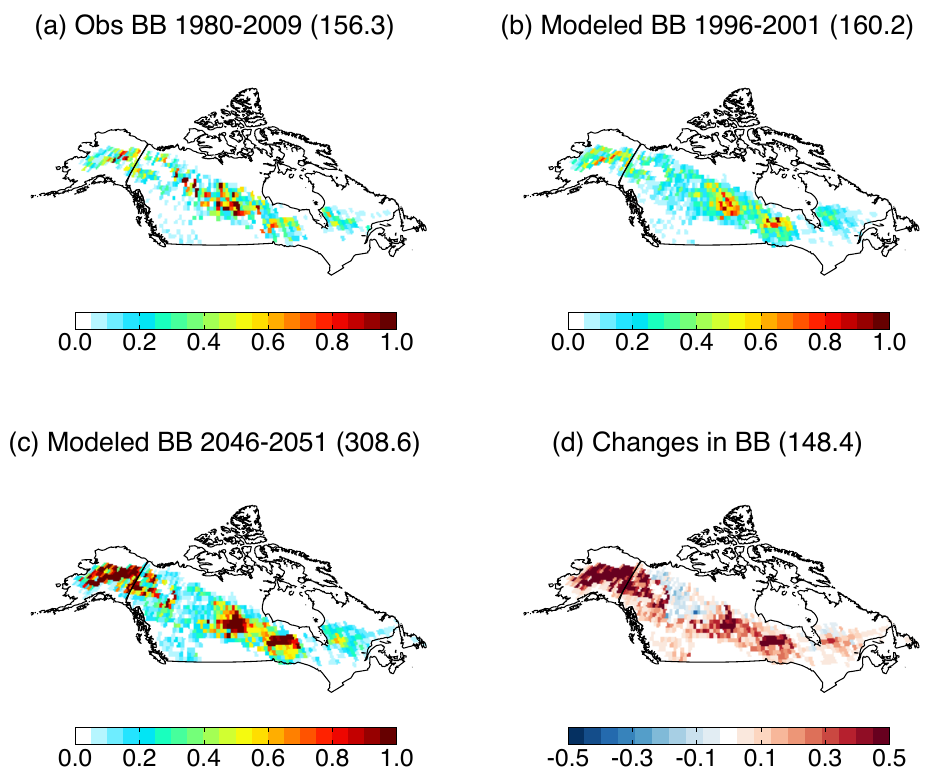
Figure 8. Biomass burning (BB) in Alaska and Canada in terms of dry matter (DM) burned per year, calculated as the product of area burned and fuel consumption. (a) shows values based on observations for 1980–2009, (b) the predicted values for 1996–2001, and (c) the projections for 2046–2051. The differences between mid-century and present day (c–b) are shown in (d) . Annual mean values summed over the whole domain are shown in brackets. Units: TgDMyr − 1